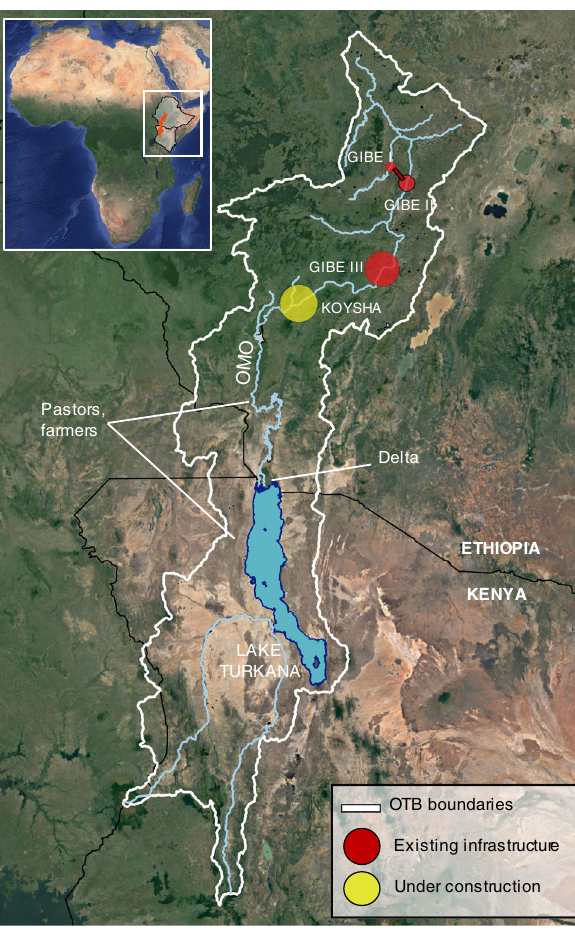
Fig. 1 Geography of the Omo-Turkana Basin (OTB). The Omo river collects the abundant rainfalls of the Ethiopian highlands and fl ows southwards through the Omo valley contributing about 90% of the annual in fl ow to Lake Turkana, where its outlet forms a complex delta across the Ethiopian-Kenyan border. About 500 thousand pastoralists and farmers inhabit the area depending on the Omo or Turkana waters for their livelihood 34 . The Gibe-Koysha dam cascade regulates the river hydrology, comprising Gibe I and II, the recently completed Gibe III, and the Koysha dam currently under construction. Marker size is proportional to the installed hydropower capacity. Basemap: Google Satellite, Map data ©2015